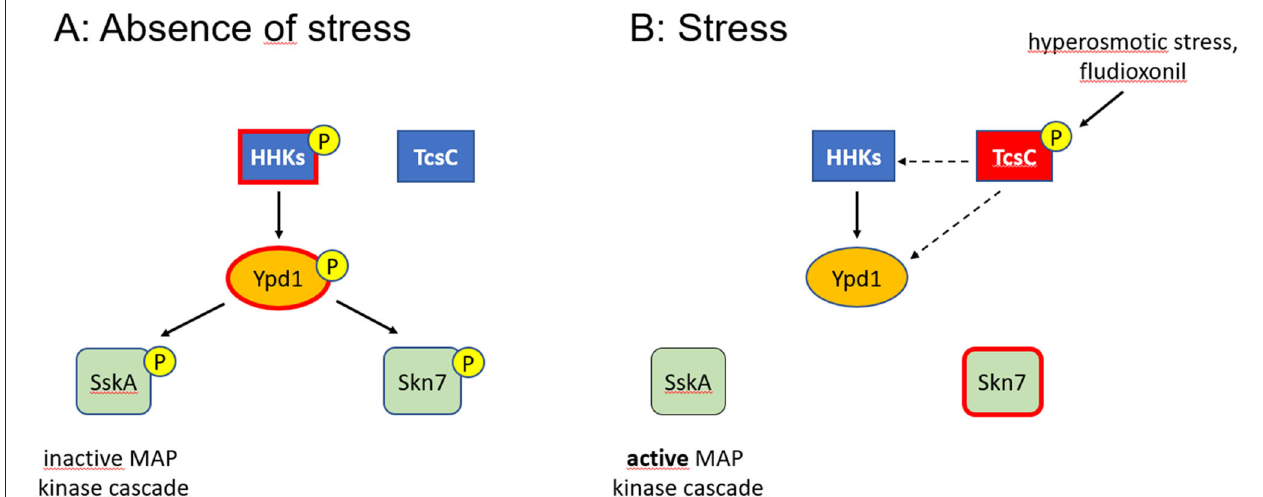
FIGURE 7 | Model of the multistep phosphorelay of A. fumigatus . Phosphorylated proteins are indicated by a (P), activated proteins by a red edge. In the absence of stress, Ypd1 is phosphorylated (most likely at residue His 89 ) and inactivates the two RRs SskA and Skn7 by phosphorylation (A) . The similar phenotypes observed